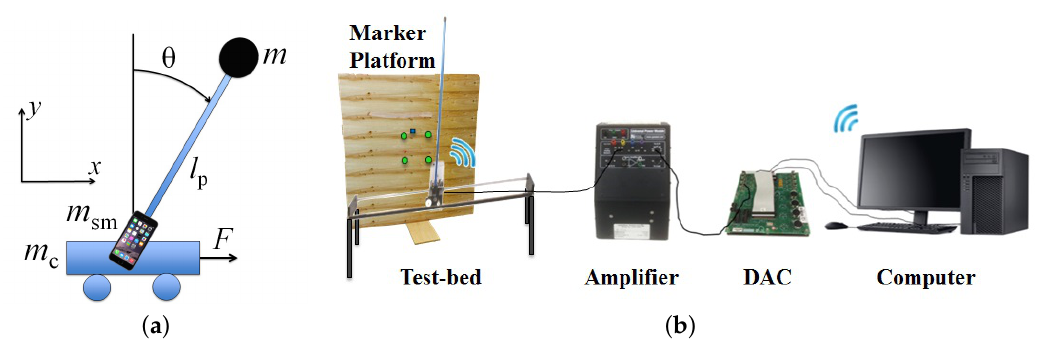
Figure 4. ( a ) A smartphone-mounted IPC system and ( b ) experimental setup with a PC-based